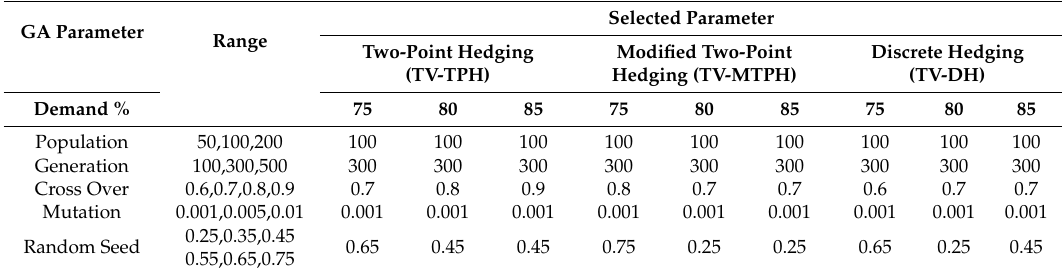
Table 3. Selected genetic algorithm (GA) parameters based on the sensitivity analysis for time-varying